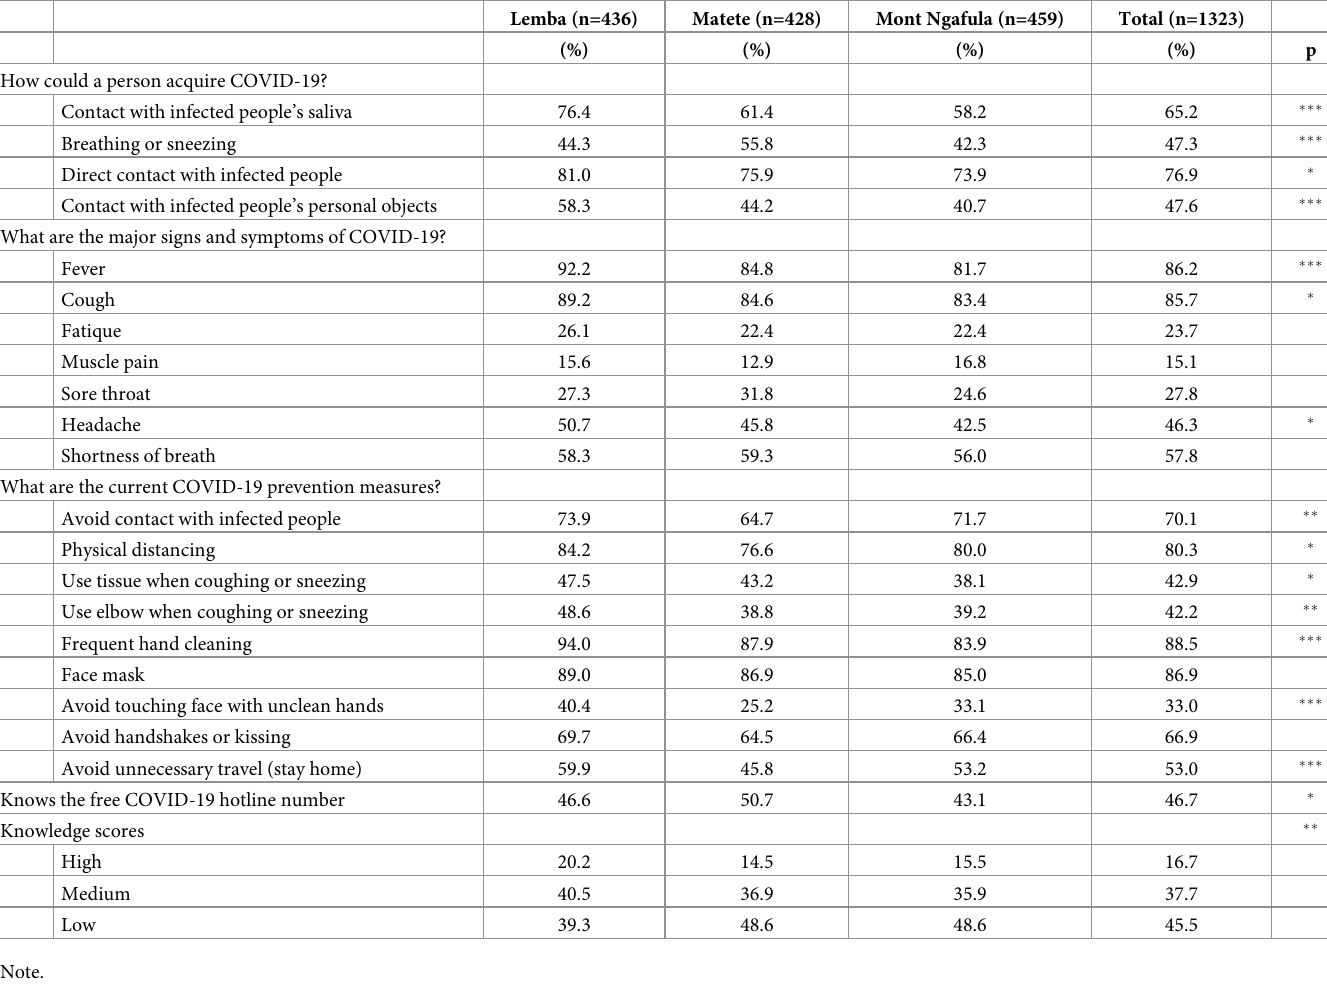
Table 2. Knowledge of COVID-19 signs, symptoms, and preventive measures by Health